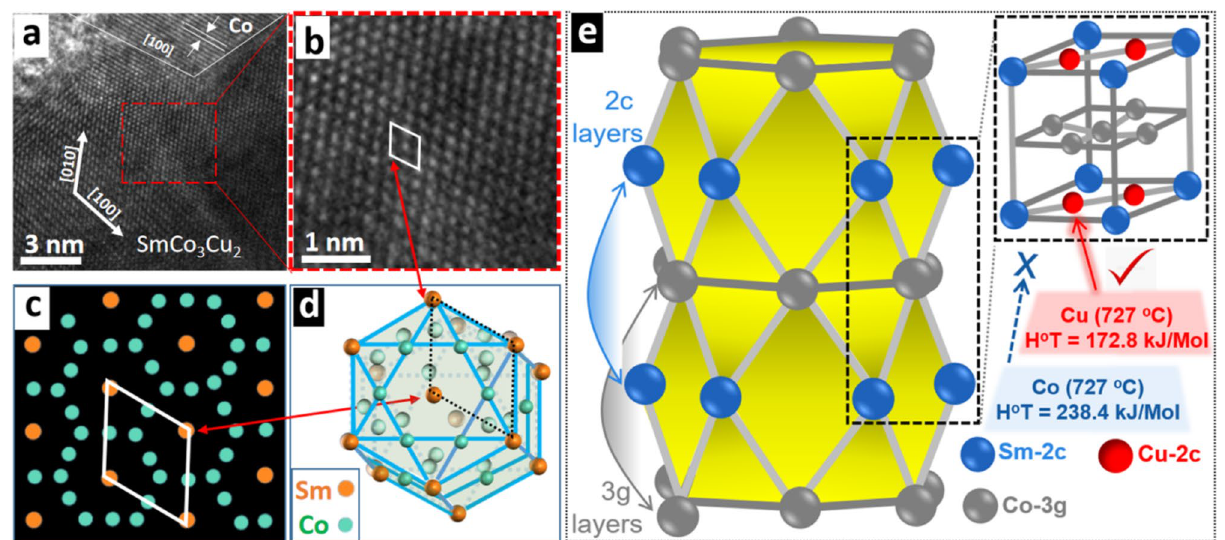
Figure 3. ( a ) HRTEM of SmCo 3 Cu 2 , ( b ) zoomed in area from the red dotted box in Fig. 2-a, ( c ) modeled SmCo 5 structure, taken along “a/b” axis, ( d ) SmCo 5−x Cu x /SmCo 5 hcp crystal structure and ( e ) arrangements of atoms in the SmCo 5 crystal lattice and the mechanism of Co substitution with Cu in “2c” layer of SmCo 5−x Cu x crystal